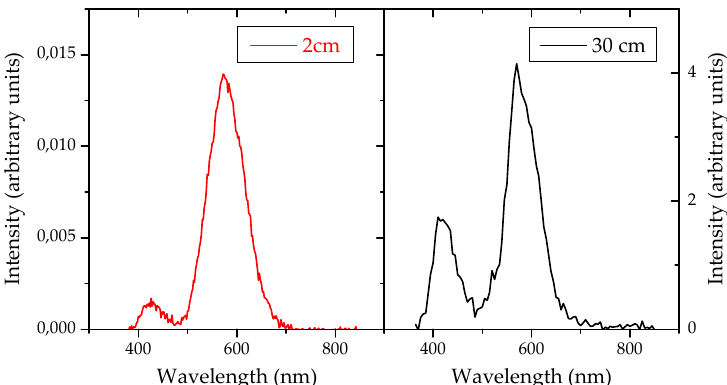
Figure 4. Photoluminescence spectra obtained from gallium oxide nanowires grown at 2 and 30 cm of the evaporating source.